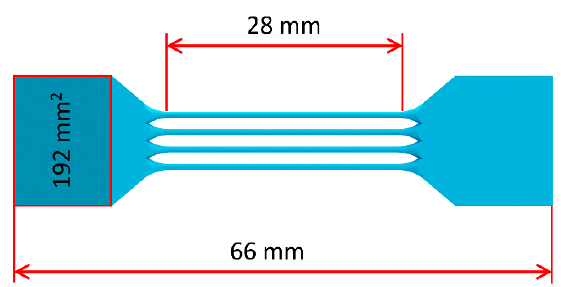
Figure 3. Multi-strut tensile sample with 12 struts.